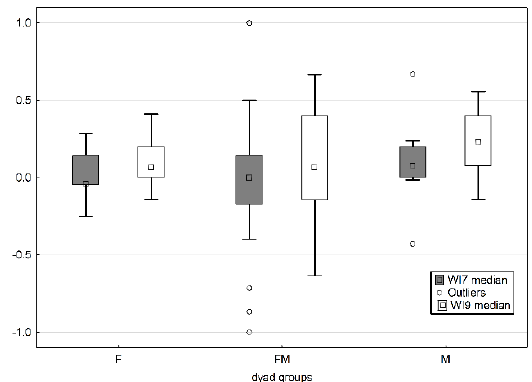
Figure 3. Box-plot graph of winning indices for 7 weeks vs. 9 weeks (WI7 vs. WI9) old dyads with respect to combination of play partners’ sexes within the dyads (F: female–female dyads vs. M: male–male dyads vs. FM: mixed-sex dyads).